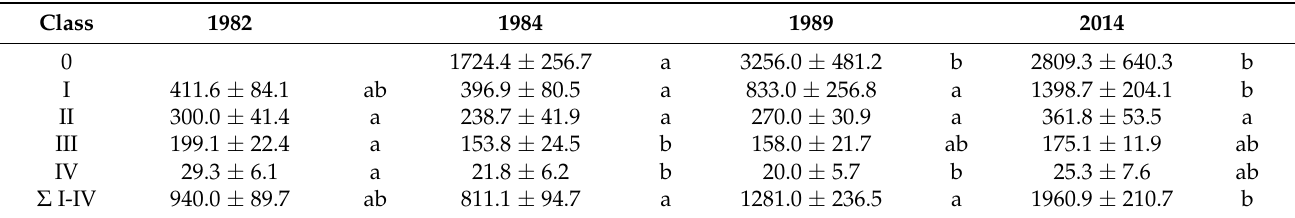
Table 2. Mean density of trees (trees/ha) ( ± standard error) in classes in four survey years. Significant differences in the mean number of trees according to different years are marked with different letters based on the Friedman test with significance p < 0.05. The same letters (a and a, ab) indicate no significant differences, and different letters (a and b) indicate significant